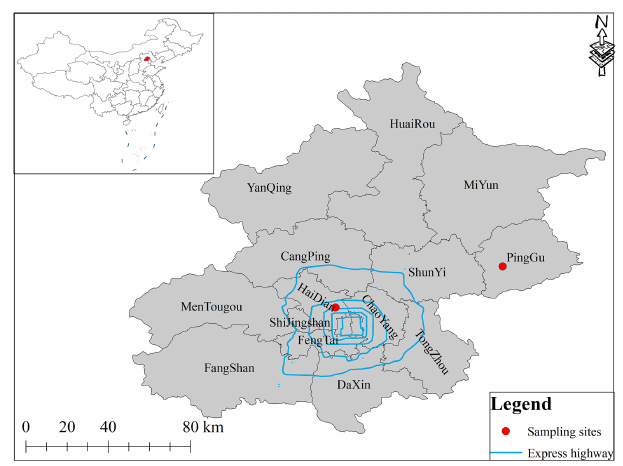
Figure 1. Map of the sampling sites.